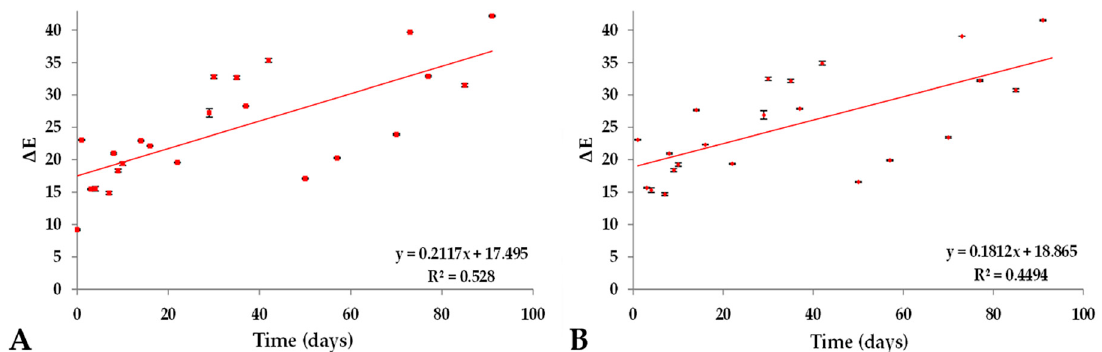
Figure 7. Color difference ( Δ E) during the stability analysis. ( A ) is a comparison between PIBP under darkness storage condition and red-colored commercial IB (brand A). ( B ) is a comparison between PIBP day 0 and next days under darkness storage condition.